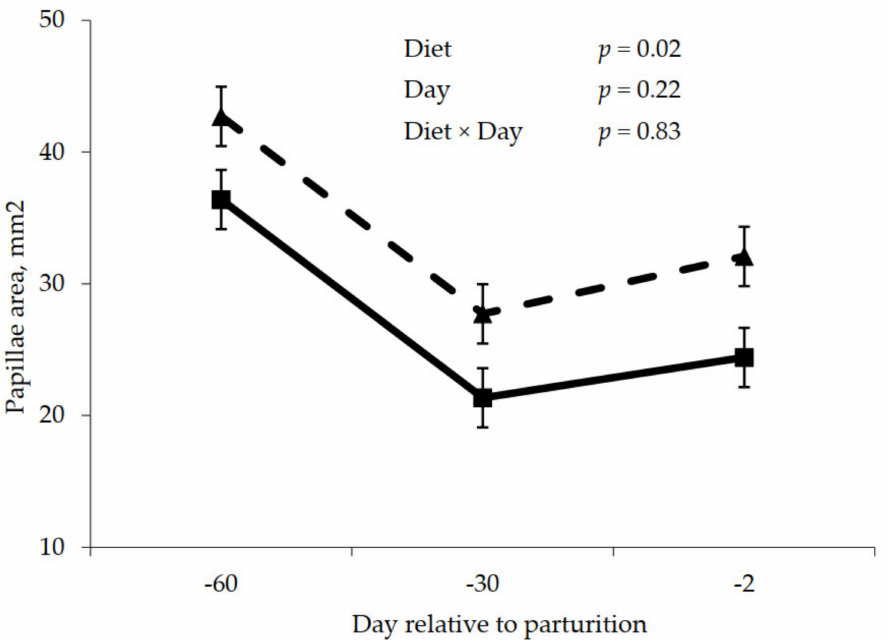
Figure 4. Prepartum papillae surface area for cows fed control (triangles) or molasses-containing (squares) diets during a 60 day dry period (error bars = pooled standard error of the mean, Experiment 2, n = 3).